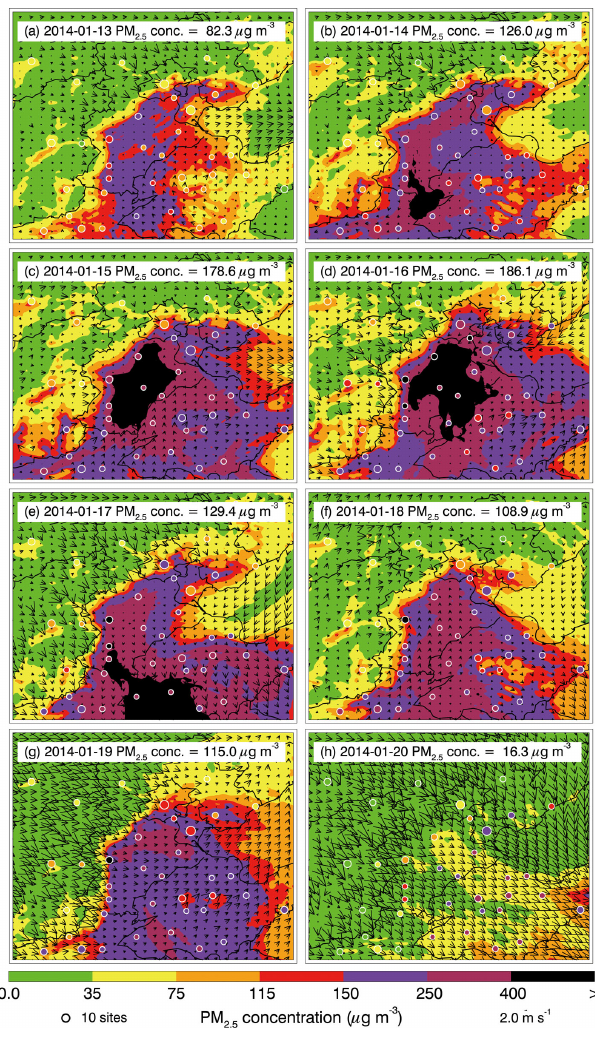
Figure 9. Same as Fig. 7 but for the ensemble member of 30 with the lowest simulated PM 2 . 5 concentration.